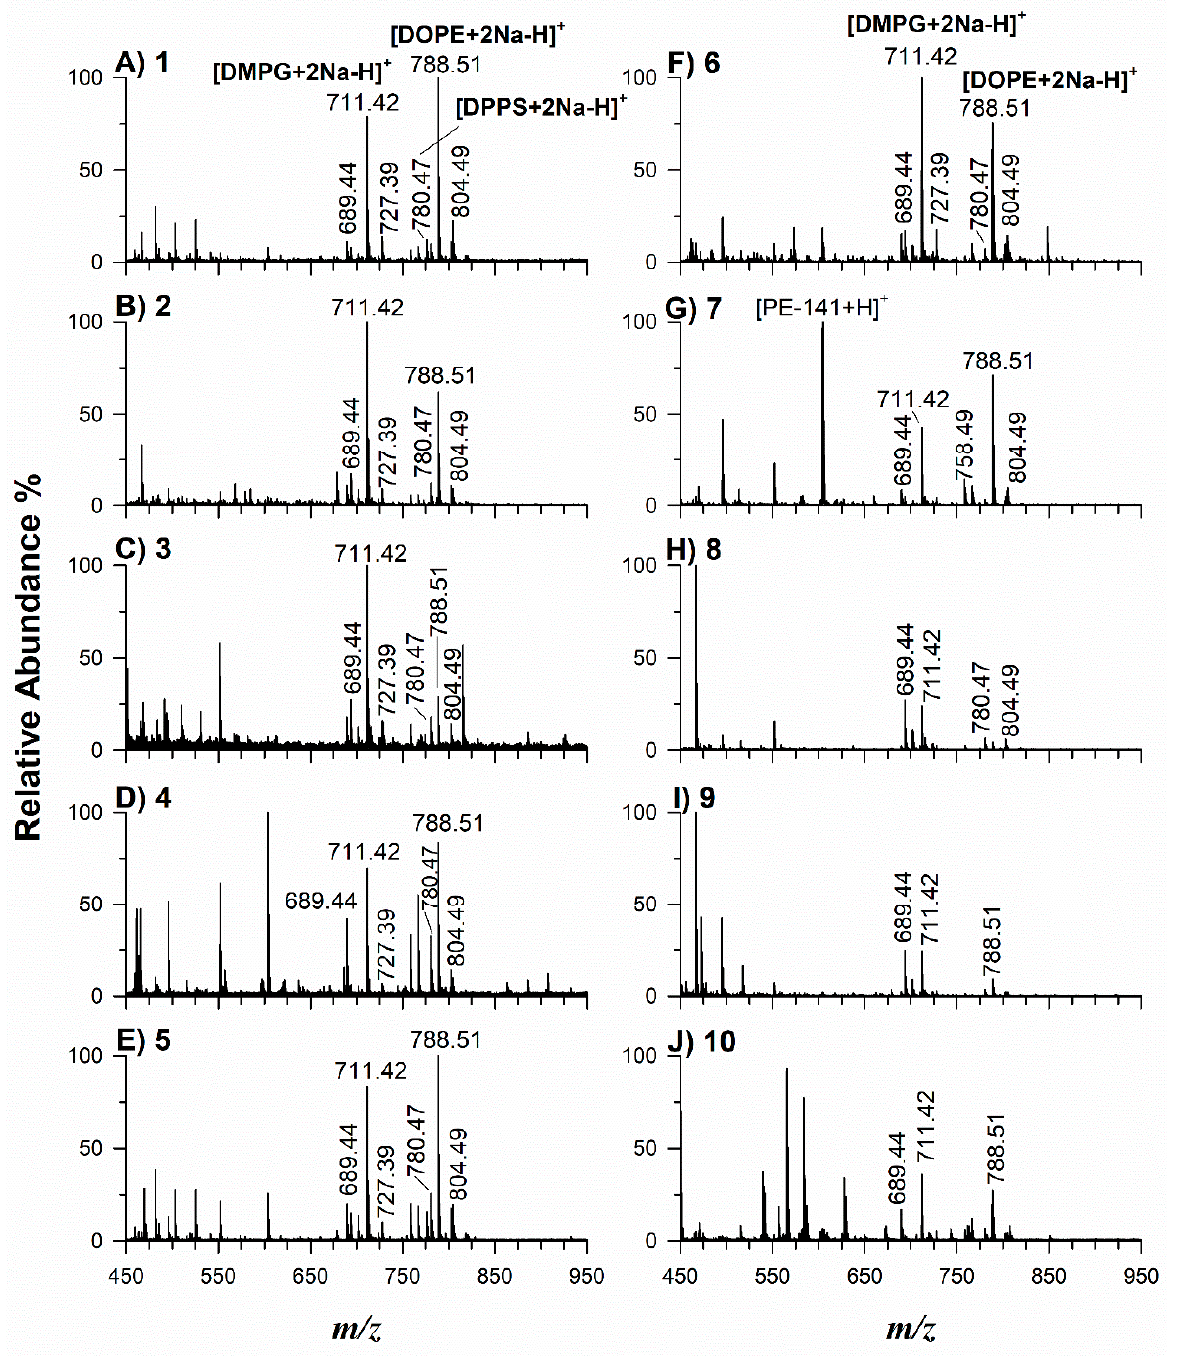
Figure 4. Positive MALDI-ToF MS spectra of the PL mixture composed of sodium salt of 1,2-dioleoyl- sn-glycero-3-phosphoethanolamine (DOPE), 1,2-dimyristoyl-sn-glycero-3-phospho-rac-(1-glycerol) (DMPG), 1,2-dipalmitoyl-sn-glycero-3-phospho-L-serine (DPPS) mixed with each matrix ( A – J ).